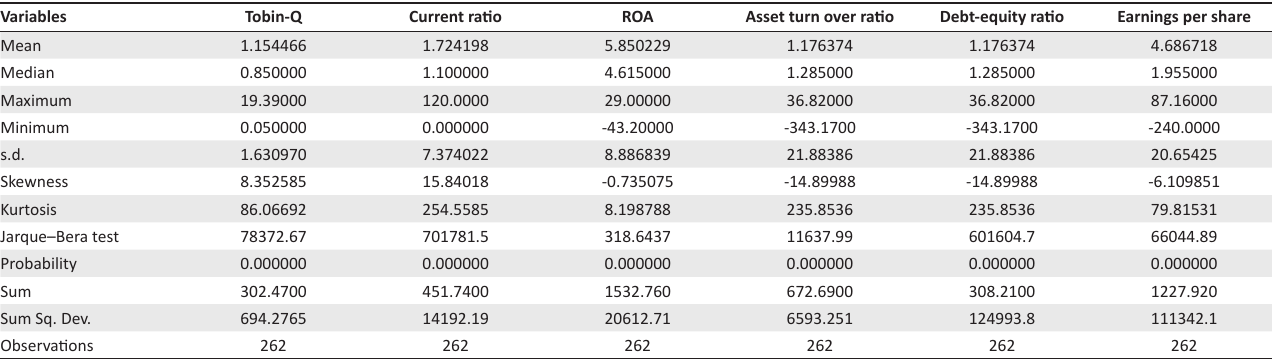
TABLE 1: Descriptive